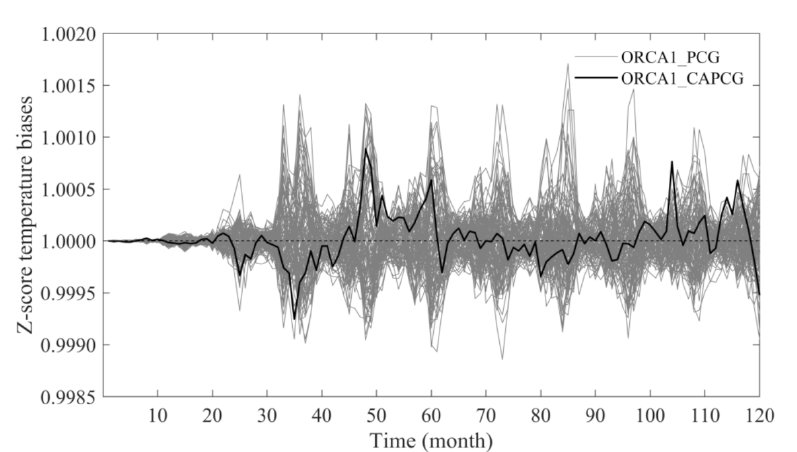
Figure 4. Z-score biases of temperature in ensemble run (grey lines) and the communication-avoiding Krylov subspace method with a preconditioned conjugate gradient (CA-PCG) solver experiment (black line). The dashed line represents the mean value of the z-score biases of all the ensemble